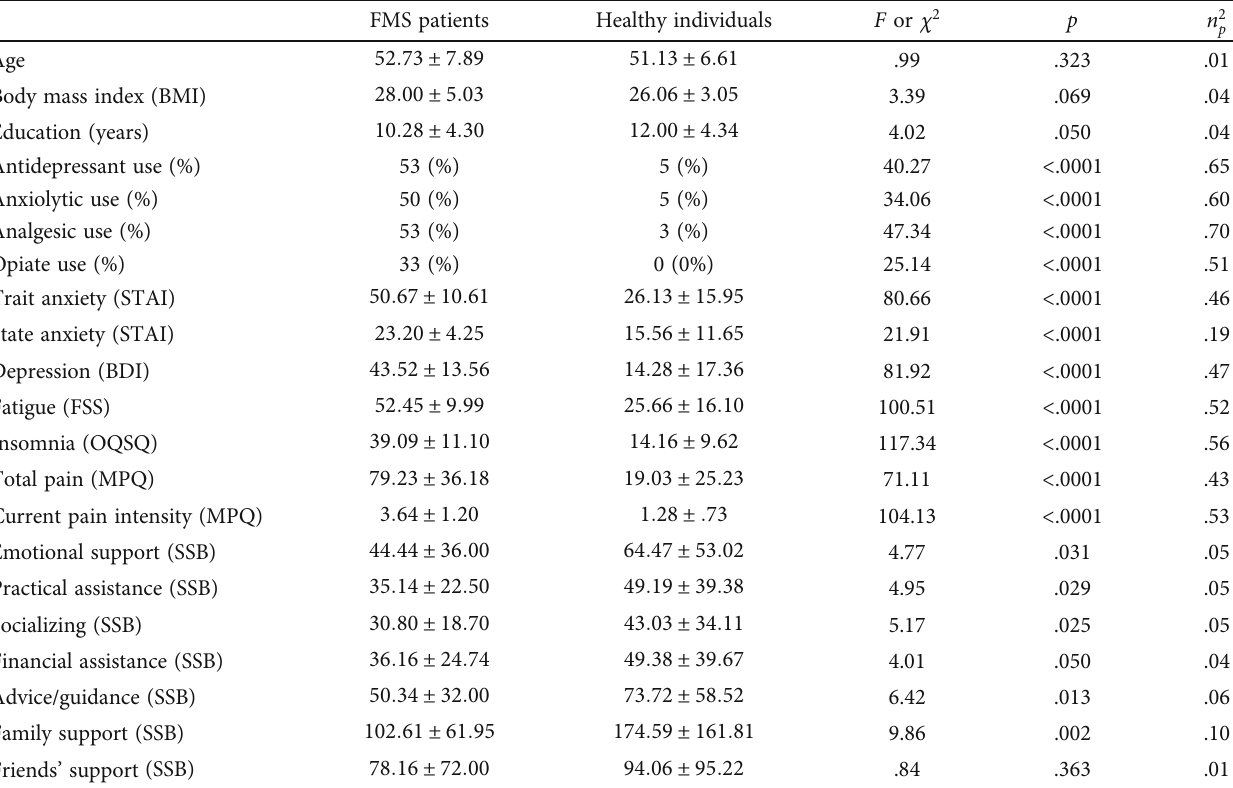
Table 1: Sociodemographic and clinical variables and questionnaire scores in FMS patients ( N = 64 ) and healthy individuals ( N = 32 ) groups ( M ± SD or number and %). Statistics of group comparisons are also included ( F -test or χ 2 -test). FMS